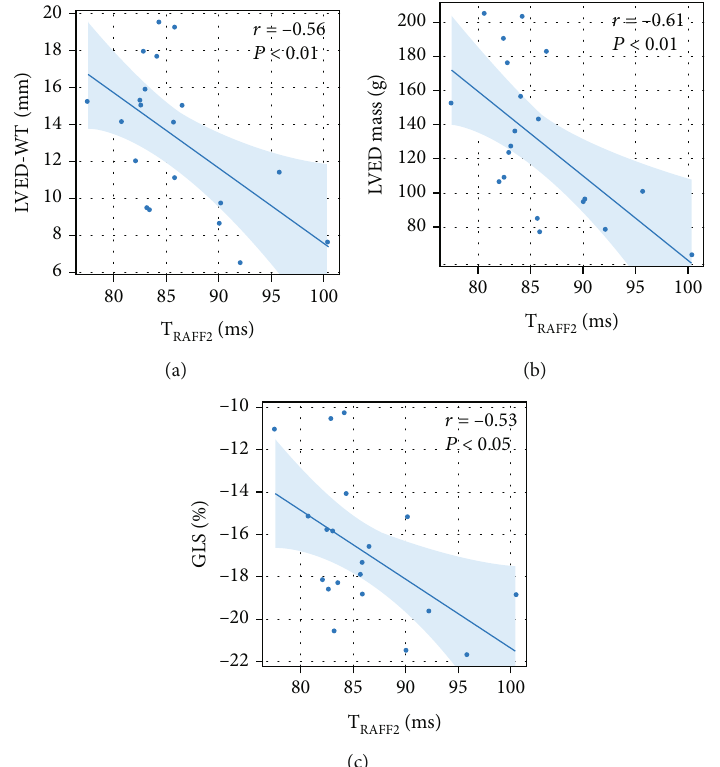
Figure 4: Pearson correlation ( r ), RAFF2 relaxation time (ms) associated with LVED-WT (mm), LVED mass (g), and GLS (%). Generalized linear model fi ts of the data with 95% con fi dence